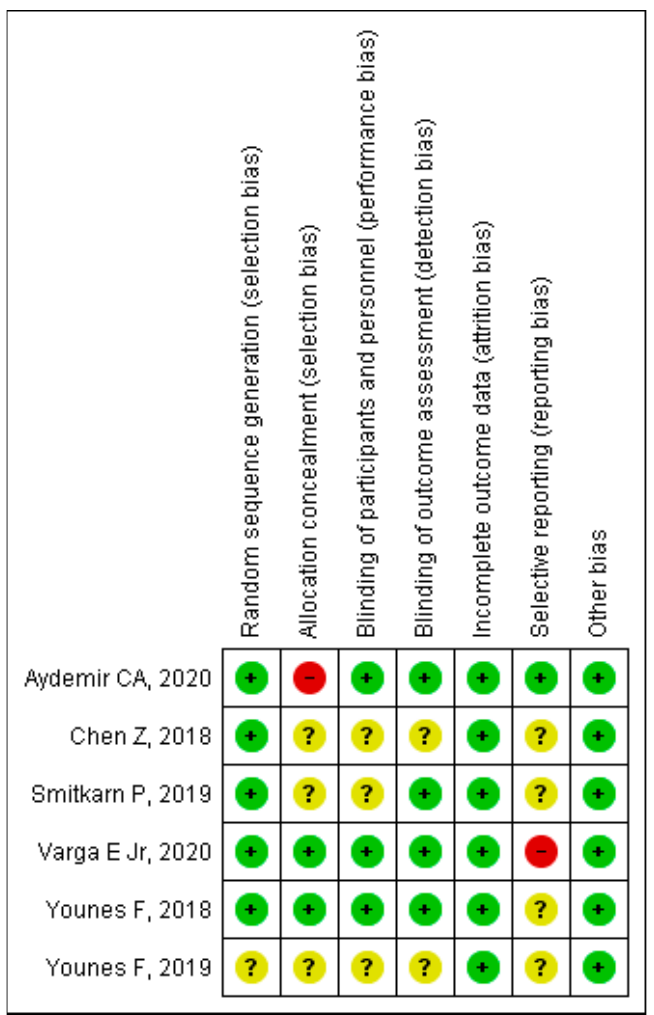
Figure 2. Risk of bias graph.